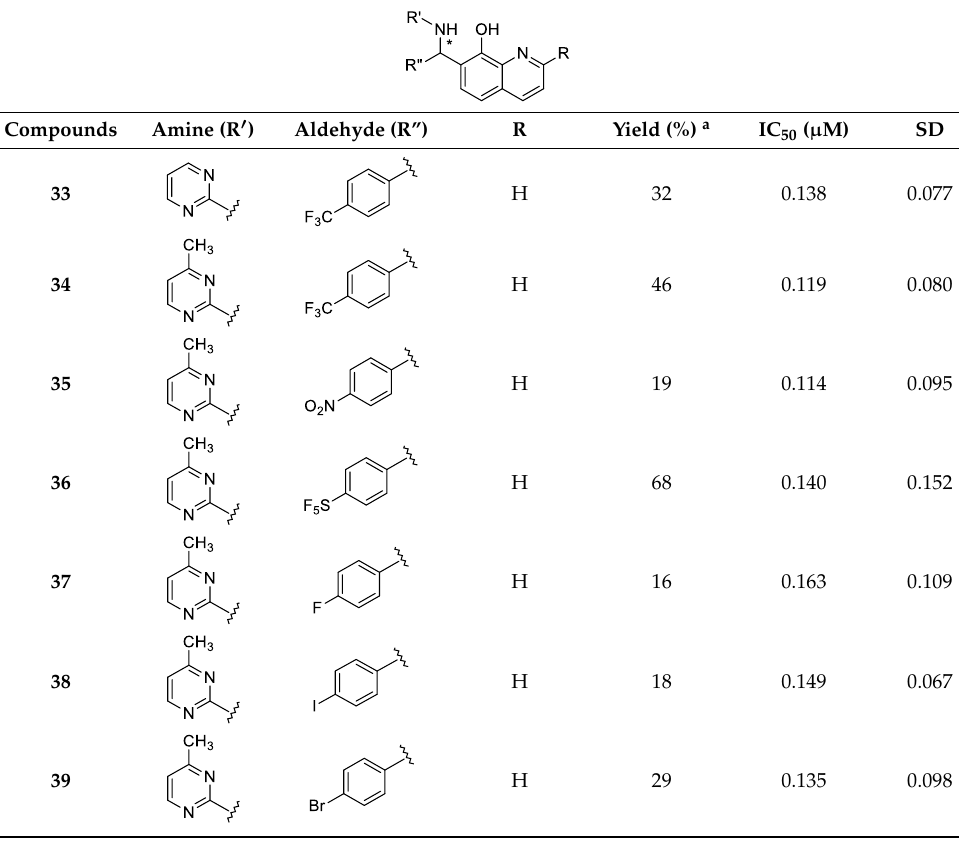
Table 3. Functionalization with several pyrimidines (Subclass 3).